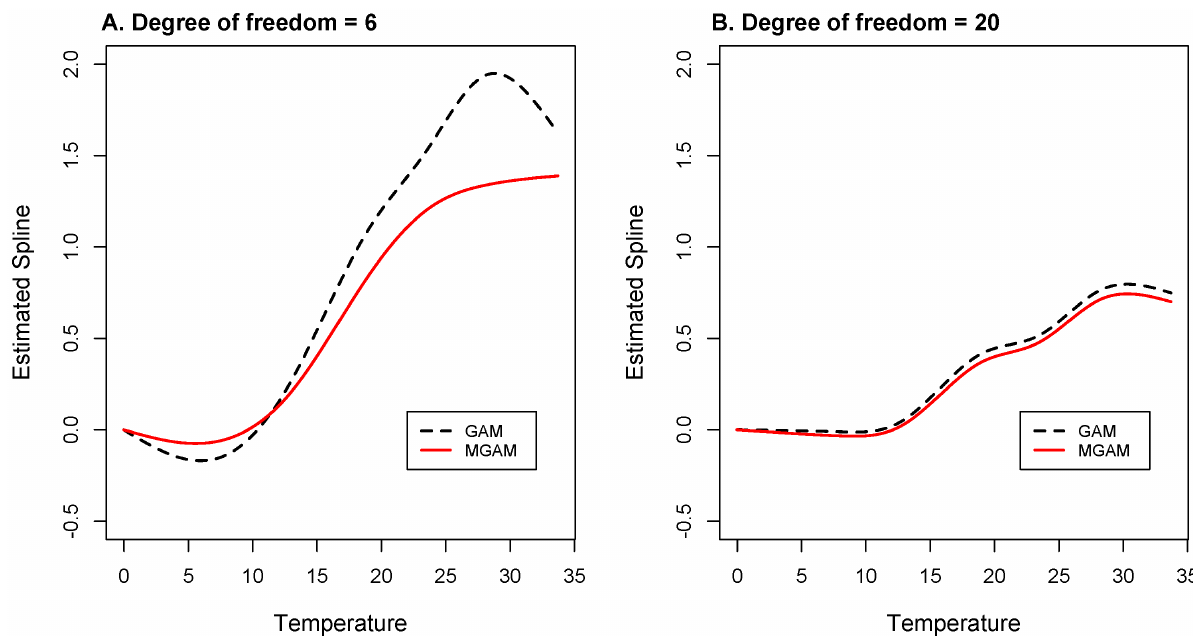
Figure 7. Estimated spline for temperature effect of MGAM and GAM. A. Temperature effect of MGAM and GAM estimated with df t =6. B. Temperature effect of MGAM and GAM estimated with df t =20. The red solid lines in both plots are the estimated spline for temperature effects on BD counts of MGAM model, and the black dashed lines are the estimated spline for temperature effects on BD counts of GAM model.